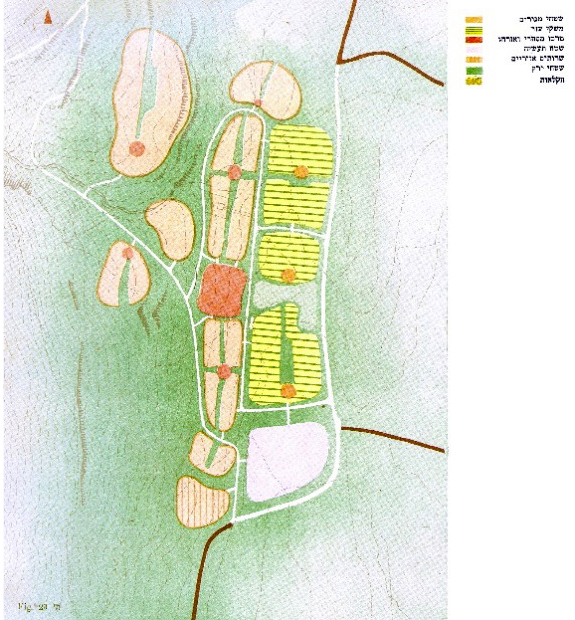
Figure 2. The neighborhood unit plan in Ashkelon’s southern neighborhoods. Notes: From top to bottom, it is written “village areas,” “rural center,” “plantings, groves,” and “agriculture.” Note that the legend refers to the urban neighborhood as if it were a village. Source: Sharon (1951, p.